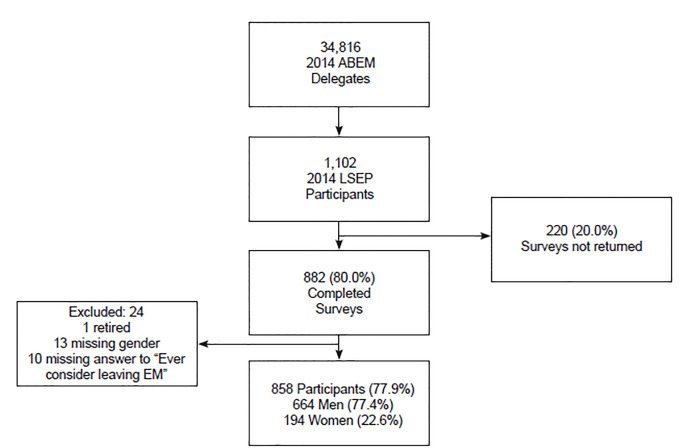
Flow diagram of participant exclusion in survey of emergency physicians.ABEM, American Board of Emergency Medicine; LSEP, Longitudinal Study of Emergency Physicians; EM, emergency medicine.